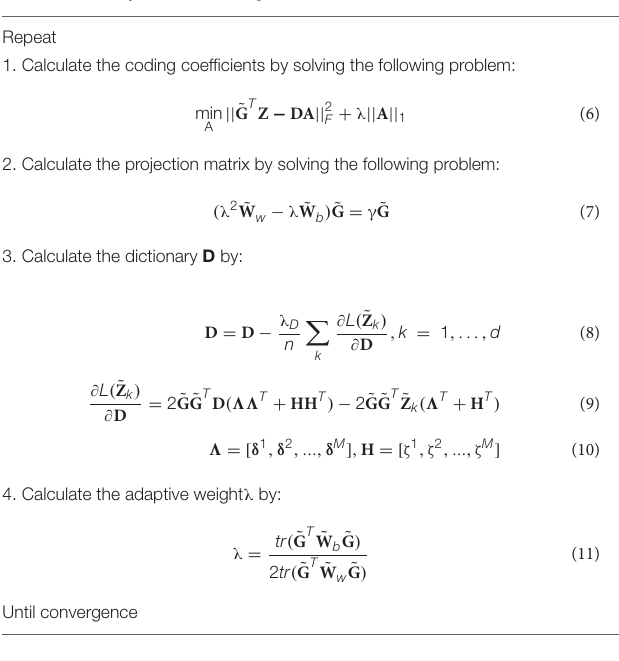
ALGORITHM 1 | The OPFDDL